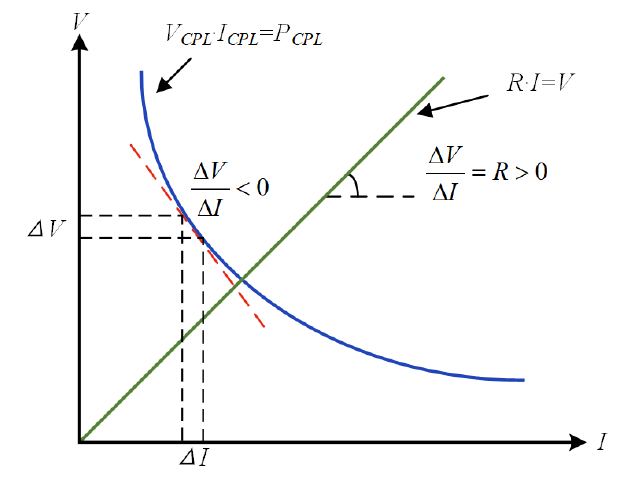
Figure 3. V-I characteristics of CPL and conventional resistive load